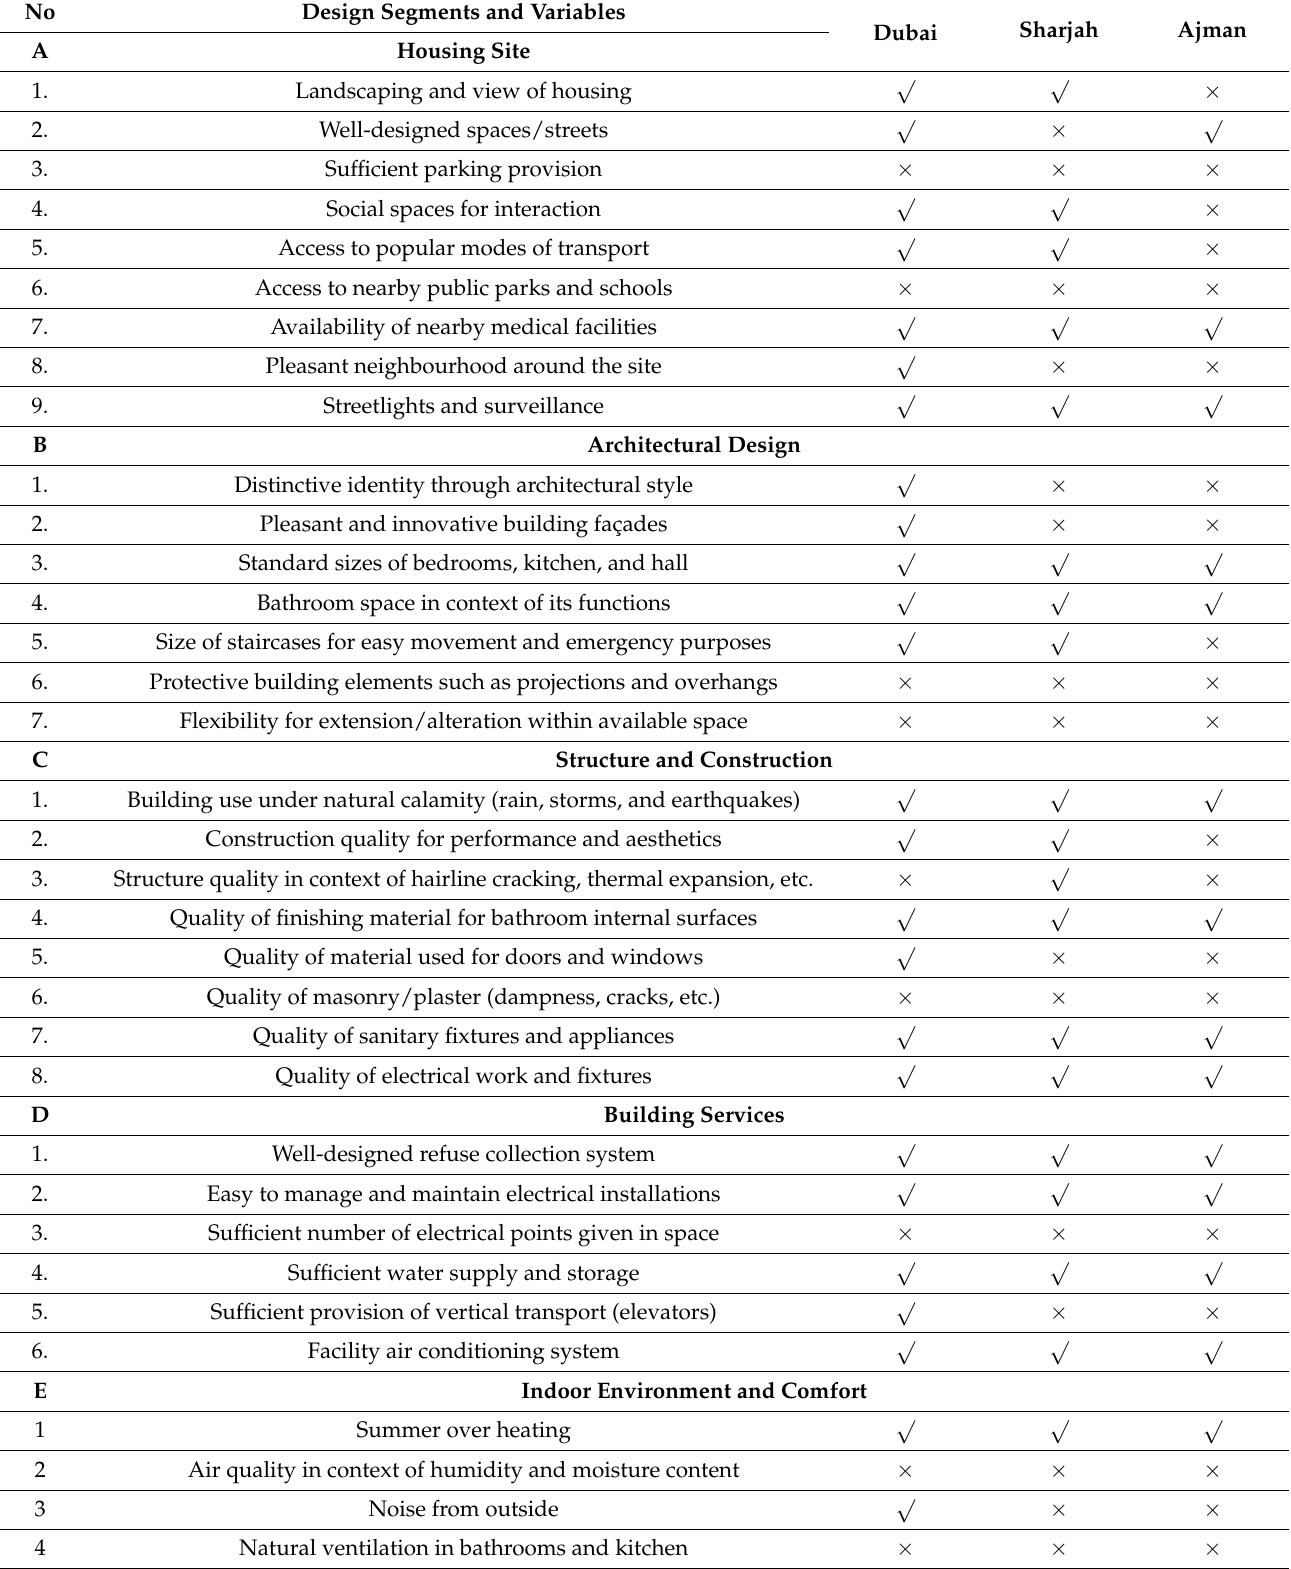
Table 1. Building design assessment